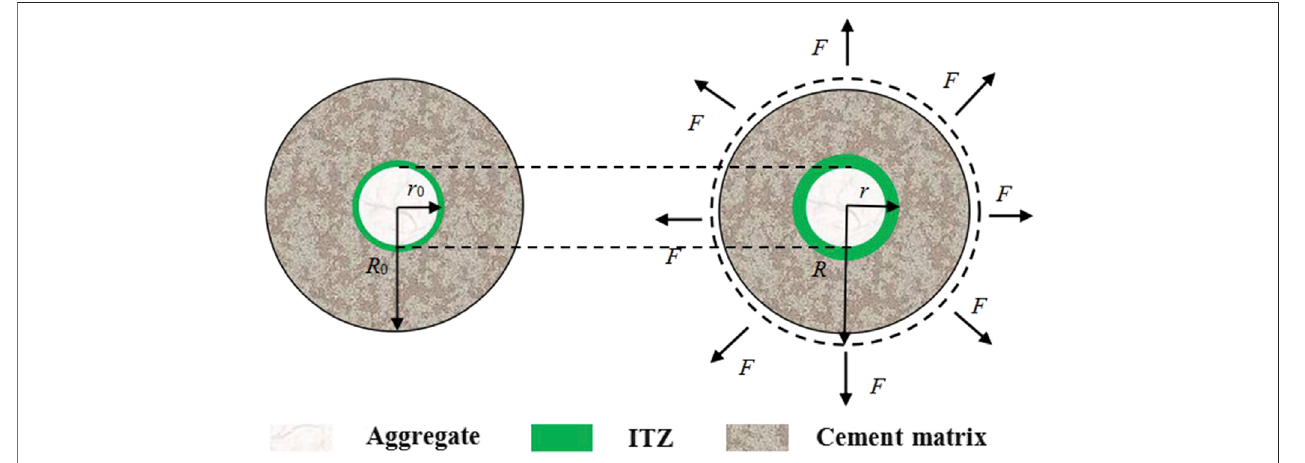
FIGURE 2 | impli fi ed spherical mechanical model of three-phase